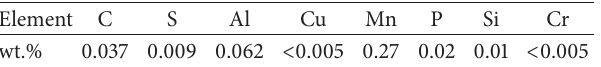
Table 1: Chemical composition of the carbon steel specimens used in this study. Element C S Al Cu Mn P Si Cr wt.% 0.037 0.009 0.062 < 0.005 0.27 0.02 0.01 <